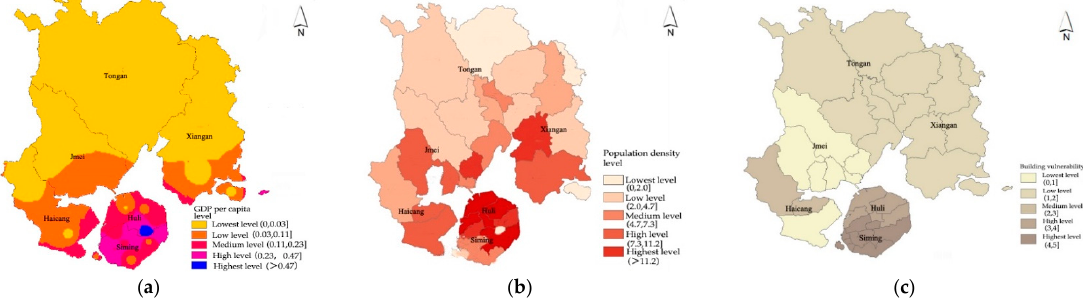
Figure 5. Vulnerability analysis of disaster-bearing bodies in Xiamen: ( a ) analysis of economic vulnerability; and ( b ) analysis of population vulnerability; ( c ) analysis of building vulnerability.